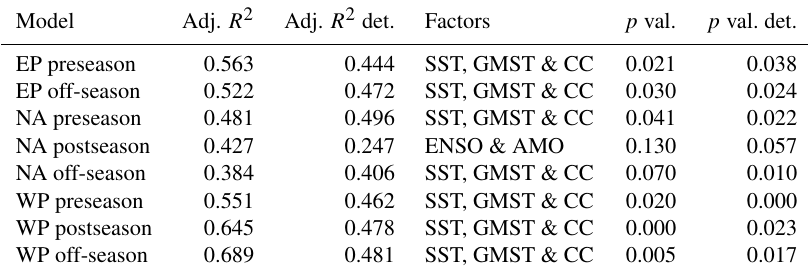
Table 3. Best multiple linear regression (MLR) models for basins with statistically significant increasing trends in off-season TCs with detrended climate